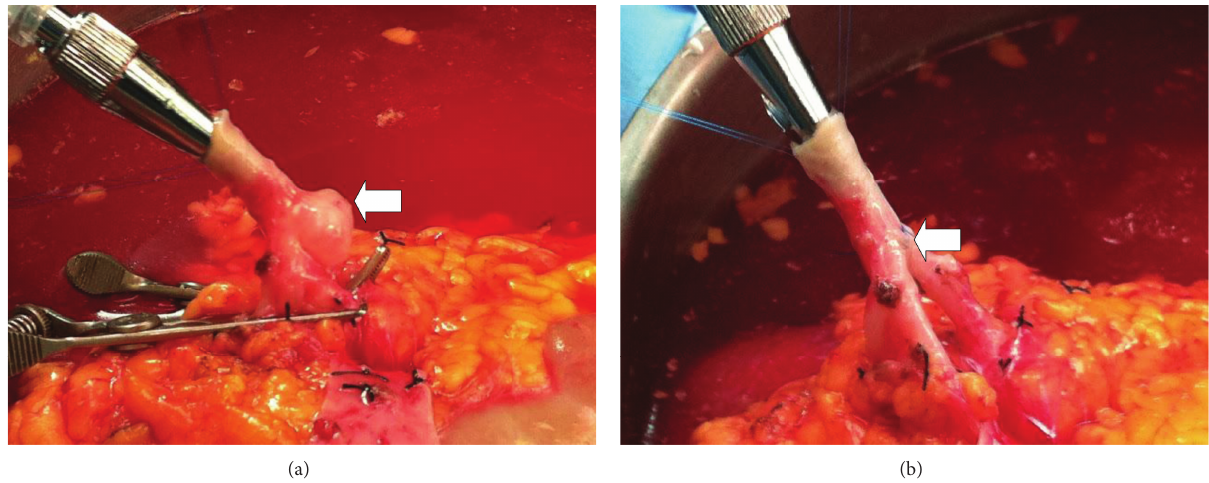
Figure 1: Saccular aneurysm of the donor renal artery before (a) and after (b) vascular reconstruction ( arrow ).